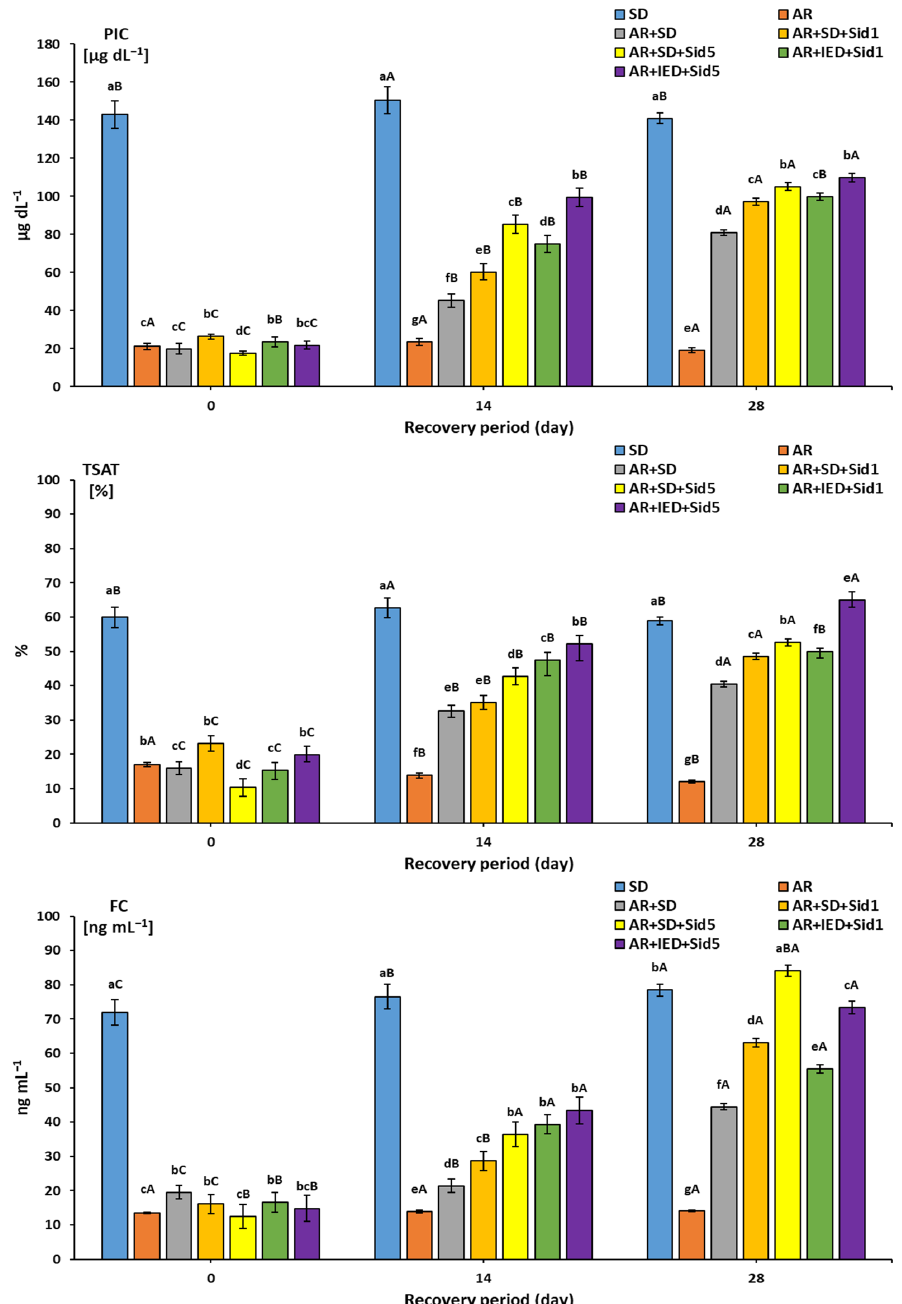
Figure 3. Plasma iron concentration (PIC), transferrin saturation % (TSAT), and ferritin concentration (FC) in rats fed different formulated experimental diets during a recovery period of up to 28 days ( n = 8). SD: standard diet, AR: anemic rat fed iron-deficient diet, AR + SD: AR fed SD, AR + SD + Sid1: AR fed SD and intraperitoneally injected with Sid at 1 μ g Kg − 1 rat twice per week, AR + SD + Sid5: AR fed SD and intraperitoneally injected with Sid at 5 μ g Kg − 1 rat twice per week. AR + IED + Sid1: AR fed iron-enriched diet (IED) and intraperitoneally injected with Sid at 1 μ g Kg − 1 rat twice per week, AR + IED + Sid5: AR fed IED diet and intraperitoneally injected with Sid at 5 μ g Kg − 1 rat twice per week, a,b,c,d,e,f,g : bars for the same recovery day not sharing similar letters are significantly different ( p > 0.05), A,B,C : bars for each treatment not sharing similar letters during the recovery period are significantly different ( p > 0.05).